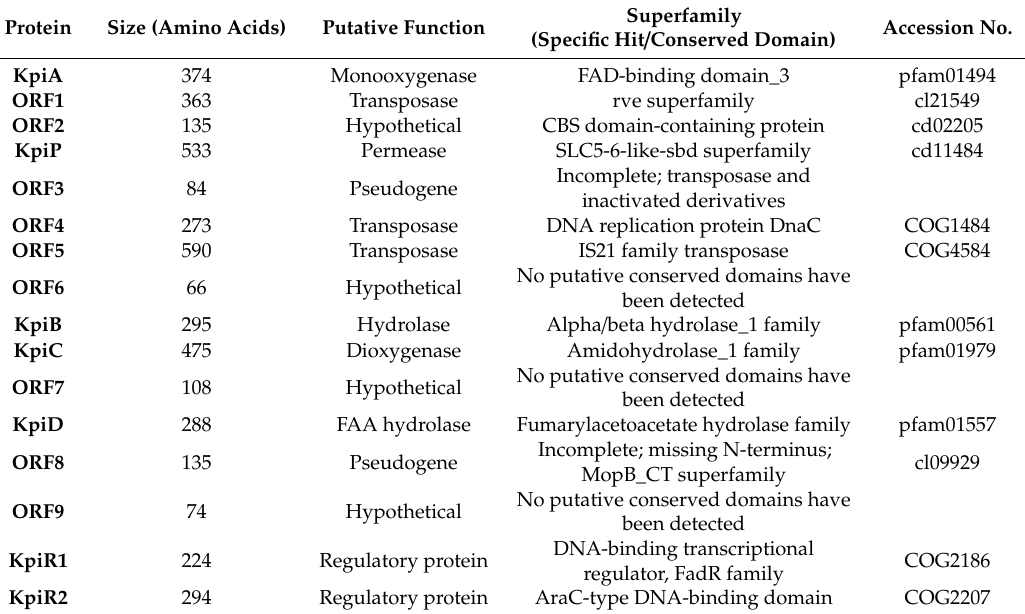
Table 1. Functional Annotations of Hypothetical Kpi